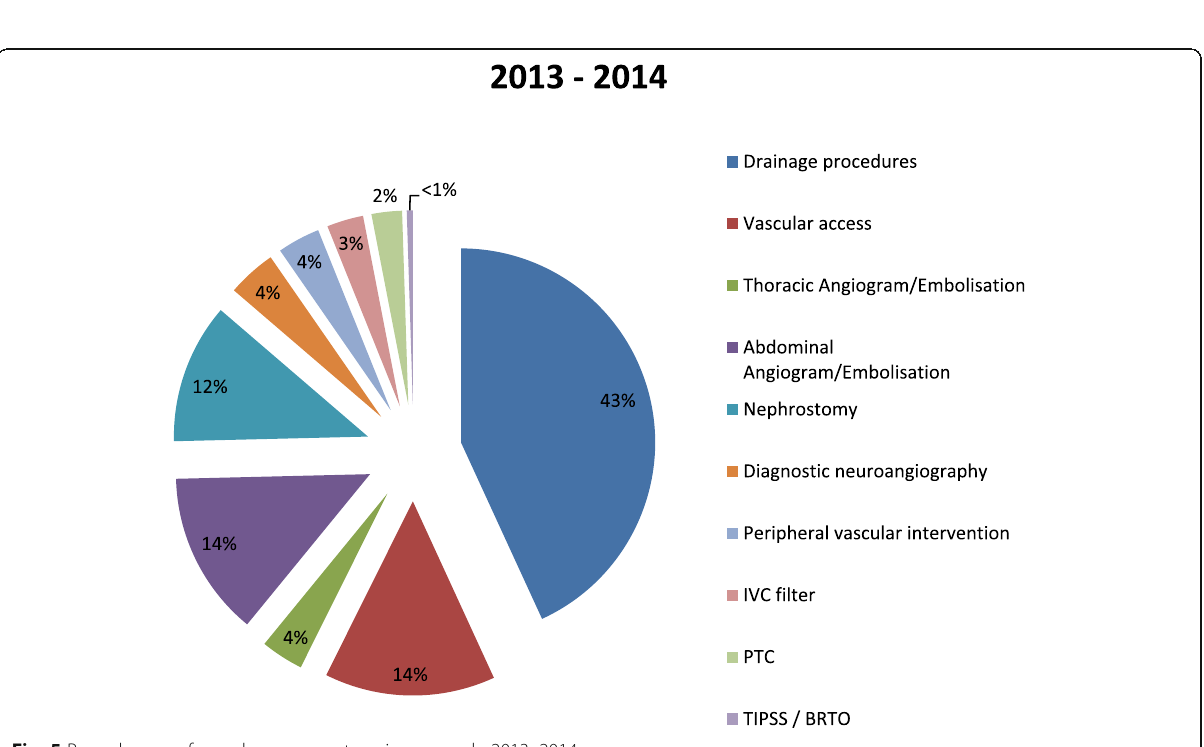
Fig. 5 Procedures performed as a percentage in year cycle 2013 –